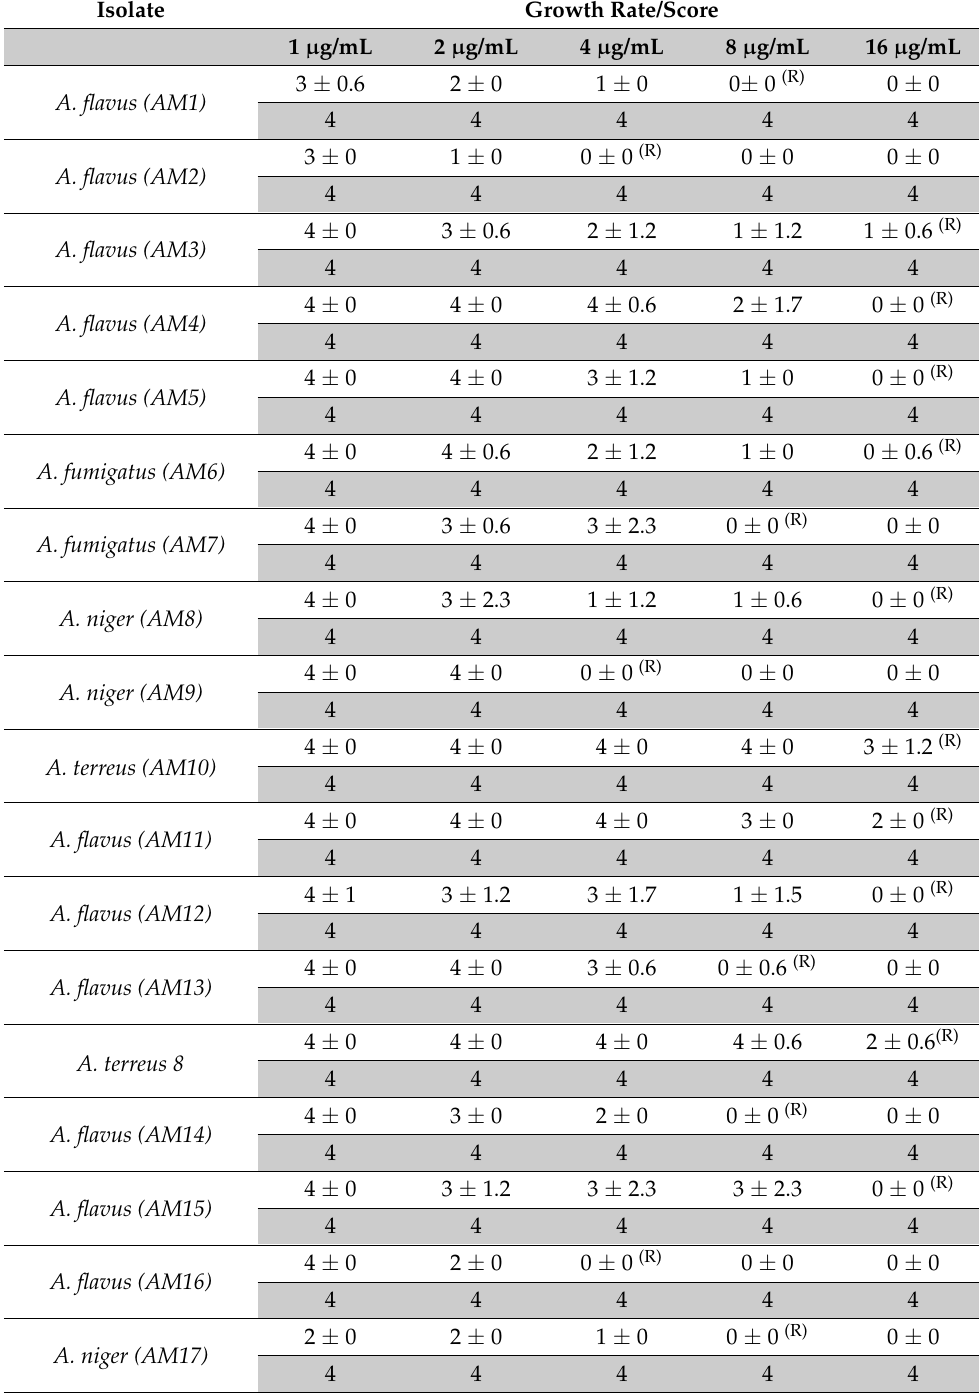
Table 5. Susceptibility of fungal species to different concentrations of Amphotericin B (broth microdi- lution